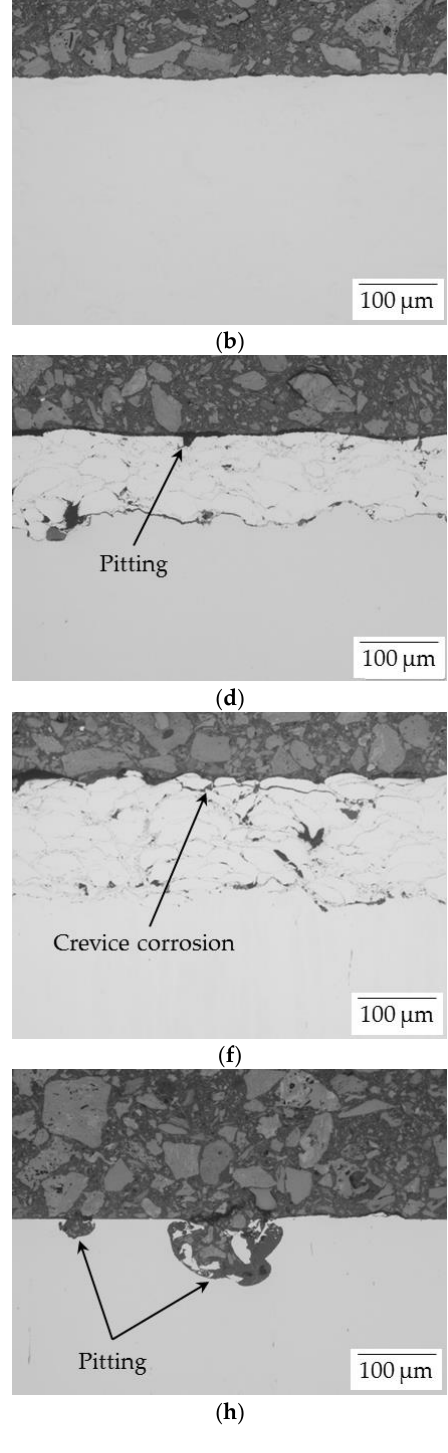
Figure 6. Representative top views and cross-sectional images of ( a , b ) reference material mild steel, ( c , d ) AISI 316L HVAF coating on mild steel, ( e , f ) AISI 316L HVAF coating on stainless steel, and ( g , h ) reference material stainless steel after potentiodynamic polarization in 3.5% NaCl solution up to +1000 mV relative to the OCP.